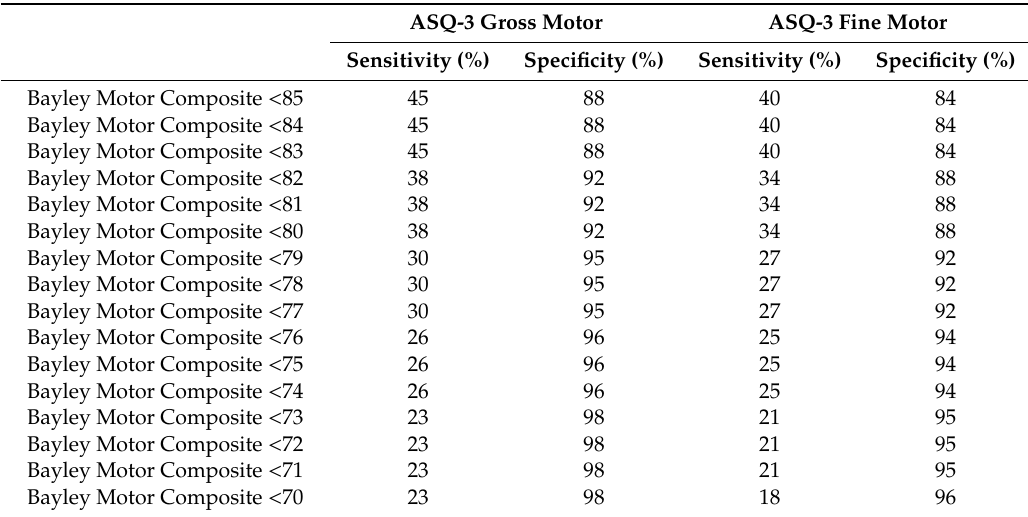
Table 6. Sensitivity and Specificity of Bayley-III Motor Composite Scores at 18 months CA with Poor ASQ-3 Motor Outcomes (monitoring zone or abnormal range) at 3 years